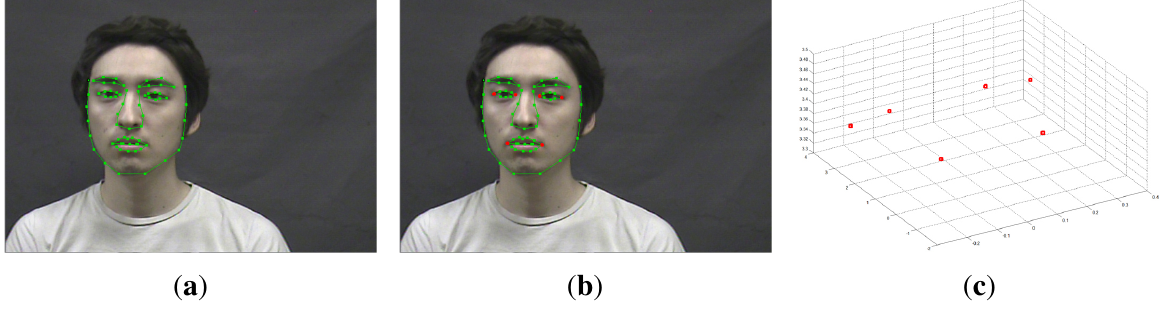
Figure 11. 3D face feature extraction. ( a ) Result of the active appearance model; ( b ) left and right points of eyes and lip position coordinates; and ( c ) 3D reconstructed face